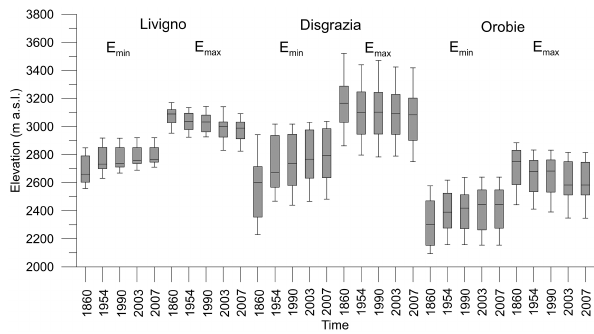
Figure 8. Change in glacier maximum ( E max ) and minimum ( E min ) elevations across the four study intervals. Horizontal lines indicate median values, boxes constrain the 25th and 75th per- centiles, and whiskers mark the 10th and 90th percentiles. Outliers are not presented due to scale constraints.